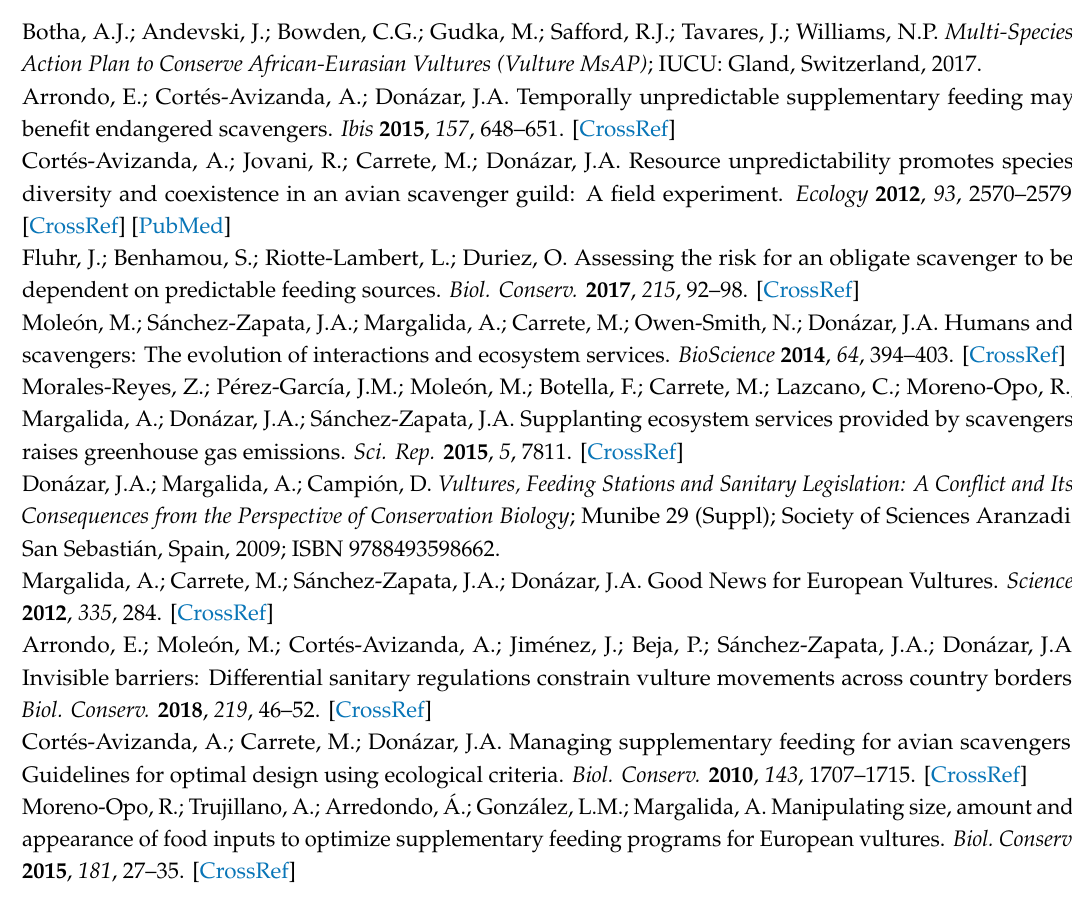
and (f) non-territorial males, Figure S4: Spline correlograms and values of Moran’s I for top-ranked model of the response variable FARMS , Figure S5: Spline correlograms and values of Moran’s I for top-ranked models of the response variable non-territorial VULTURES , Figure S6: Spline correlograms and values of Moran’s I for top-ranked models of the response variable territorial VULTURES , Figure S7: Boxplot showing distance between the largest core area defined by Kernel UD 50% for each semester and Egyptian Vulture and the closest highly predictable feeding place (HPFP), according to sex and breeding